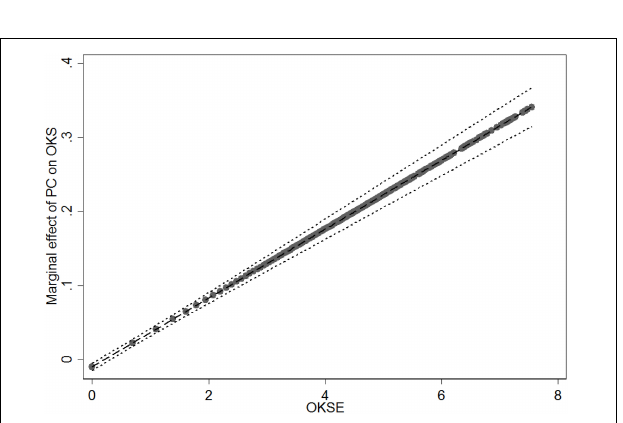
FIGURE 3 | Moderating effect of online knowledge sharing experience (OKSE) on the relationship between patients’ visit (PV) and online knowledge sharing (OKS).